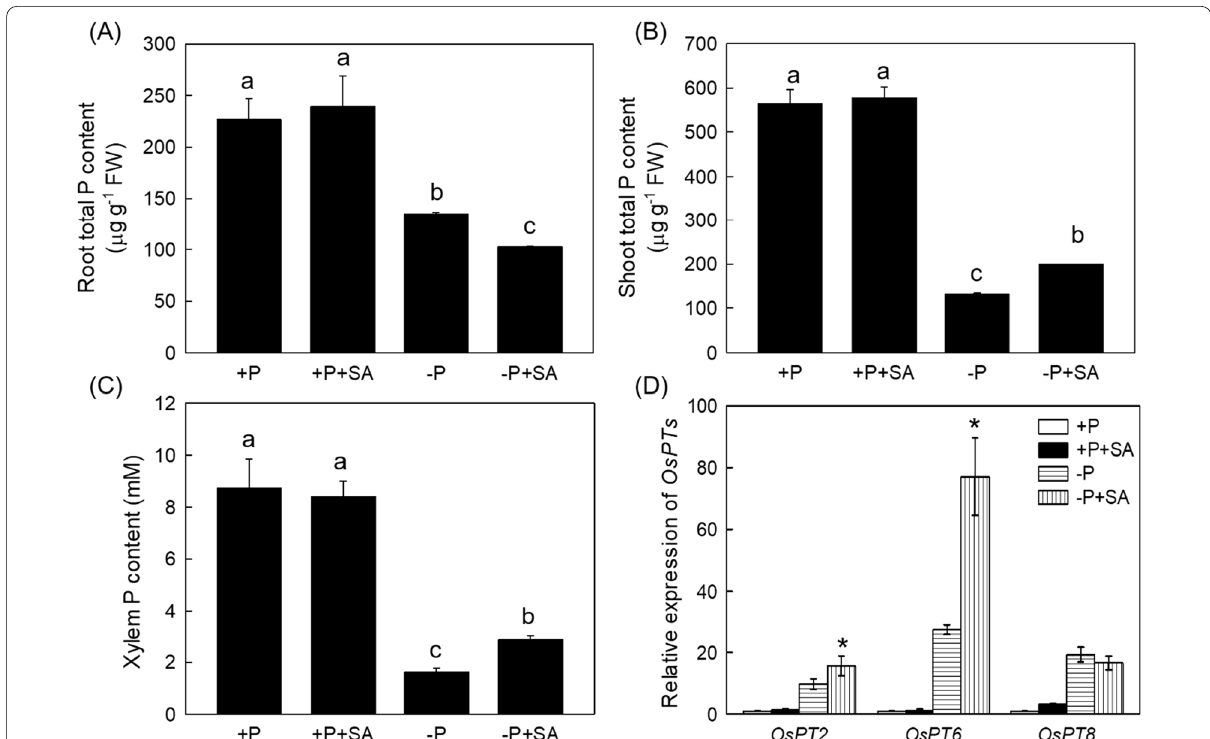
Fig. 5 SA facilitates the P translocation under P‑insufficient condition in rice. Root and shoot total P content ( A and B ), xylem P content ( C ) and the relative expression of P related transporter genes were detected. Data are means Duncan’s multiple range test at the P < 0.05 and asterisks indicate a significant difference at P < 0.05 by Student’s t